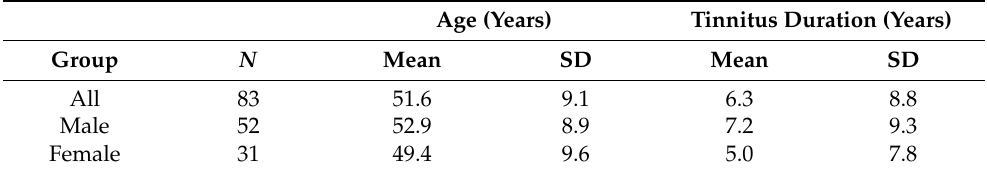
Table 1. Baseline characteristics and demographics of patients who completed the